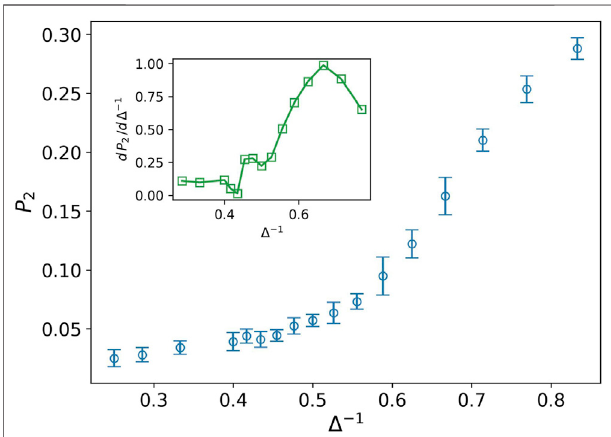
FIGURE3| Fractionofnodeswithdegreetwo P 2 (bluecircle)againstthe inverse of attraction strength, and the attraction range has a fi xed value, σ = 1.5. The error bars are the standard deviation of sampling over 20 simulation runs. The increasing behavior means more average distance between the cells in tumor. The inset plot displays a derivative of P 2 as well. The peak splits liquid-like and gas-like phases.